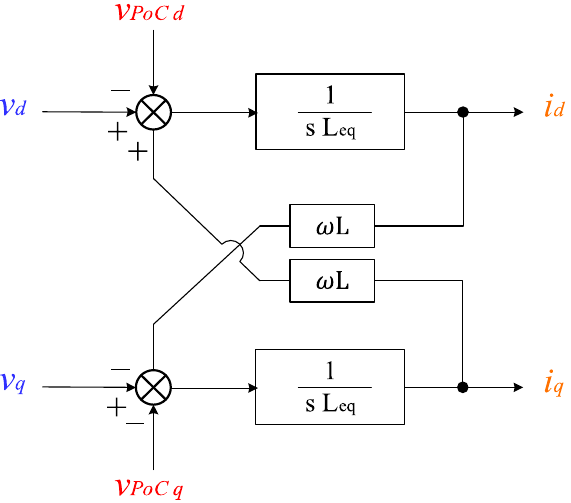
Figure 11. Equivalent grid-connected power converter model in the dq-frame. Figure 12 shows the control circuit for controlling the output current of the VSC converter modelled in the dq-frame. The grid voltage and cross-coupling components in the control circuit have the opposite signs from those indicated in the complete grid filter plant. This is done to compensate for and cancel out their influence on the system under the control.